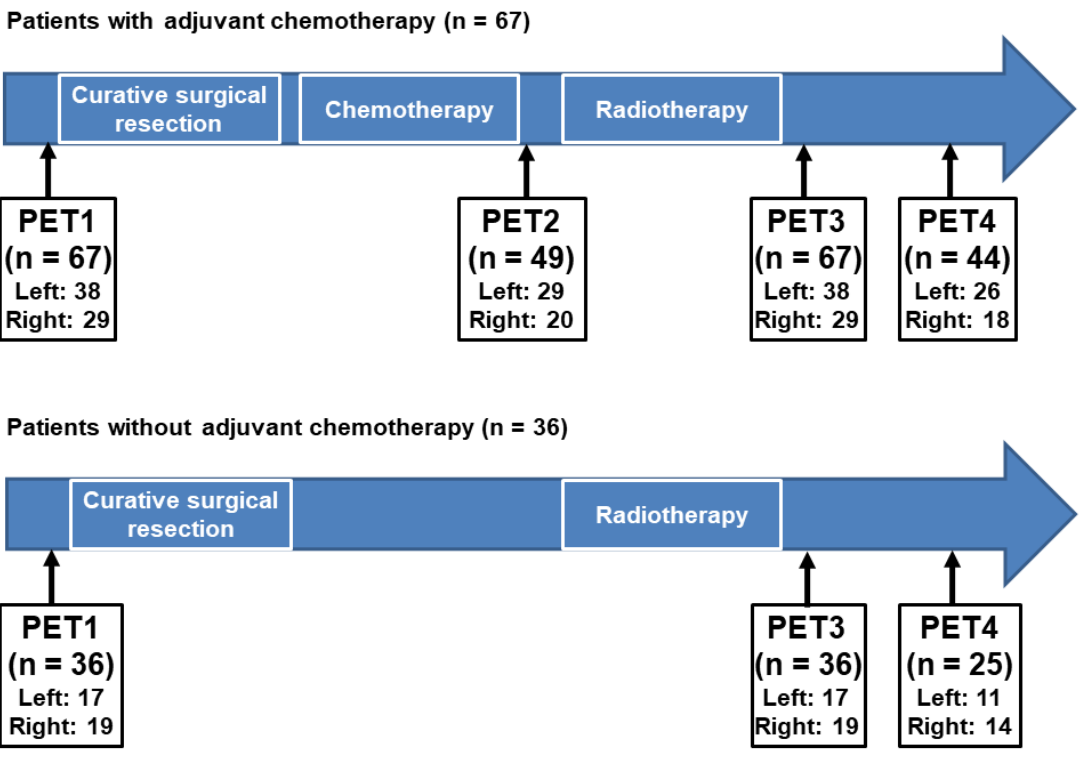
Figure 1. Clinical follow-up course of the enrolled patients. Among the enrolled patients, 67 who